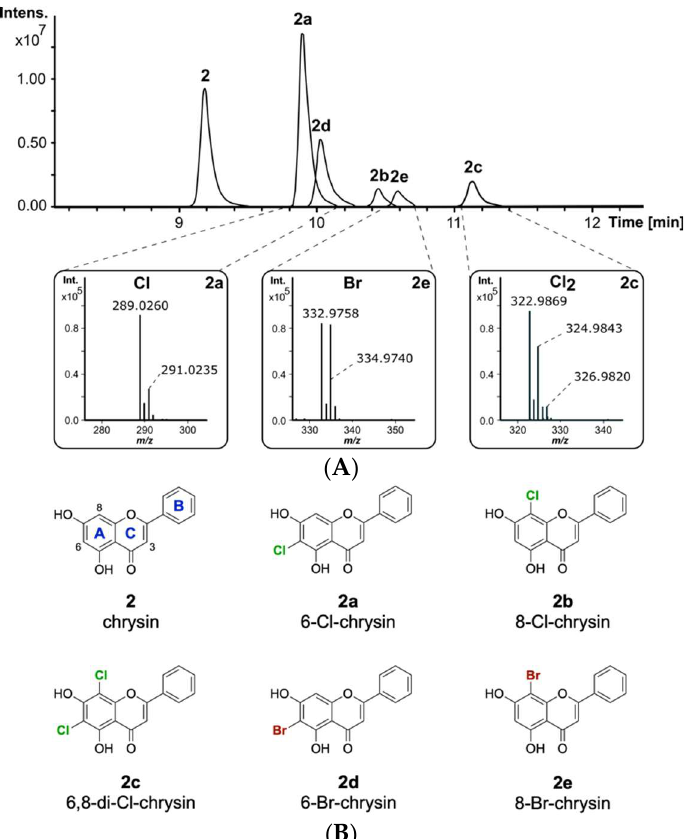
Figure 2. ( A ) Overlaid extracted ion chromatograms of the crude extracts from S. albus 9B-A9 supplemented with 2 and NaCl or NaBr. The characteristic isotope patterns of the halogenated products are shown. ( B ) The structures of the obtained halogenated derivatives of compound 2 . The structures of compounds (6-Cl-chrysin, 8-Cl-chrysin and 6,8-di-Cl-chrysin) 2a – 2c were confirmed by NMR, while the structures of 2d and 2e were predicted based on the LC-MS analysis results, the structure of chlorinated compounds and the proposed catalytic mechanism of the halogenase DklH (the flavonoid ring nomenclature and chlorine atoms are highlighted as described before, bromine atoms are colored in dark red).